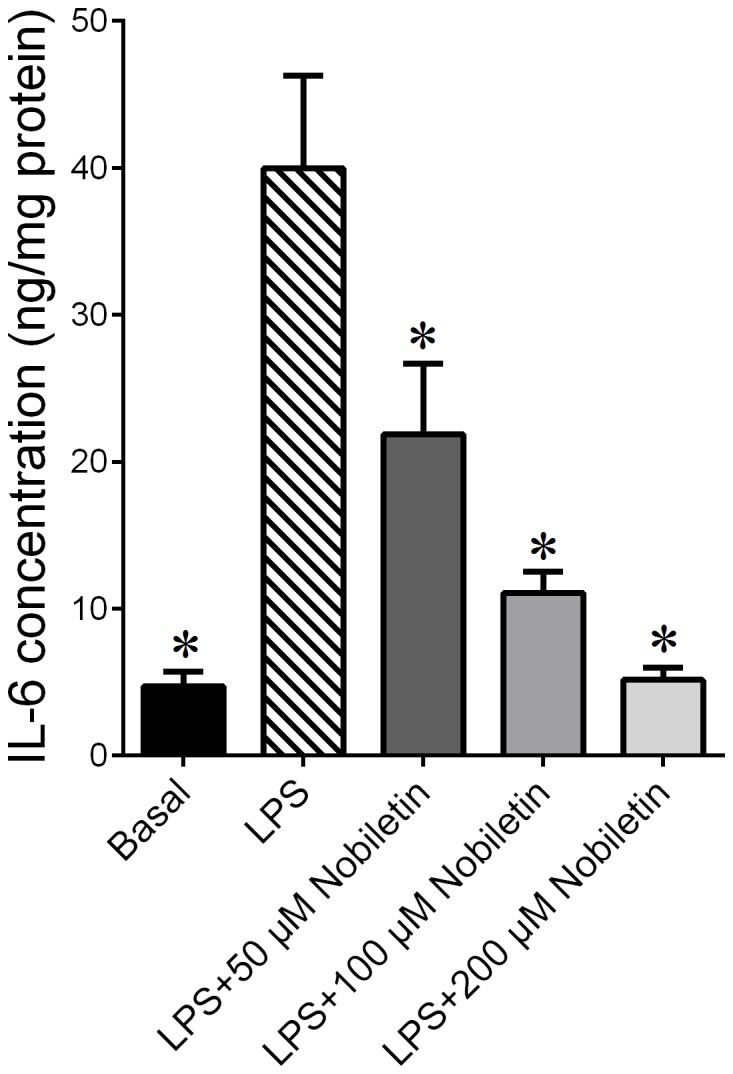
Dose Response: effect of nobiletin on LPS induced IL-6 release from term human fetal membranes.Fetal membranes were incubated with or without 10 µg/mL of LPS in the absence or presence of 50, 100, or 200 µM of nobiletin (n = 6 patients per group). IL-6 concentration in the conditioned media was assayed using ELISA. Each bar shows the mean ± SEM. *P<0.05 vs. LPS (one way ANOVA).